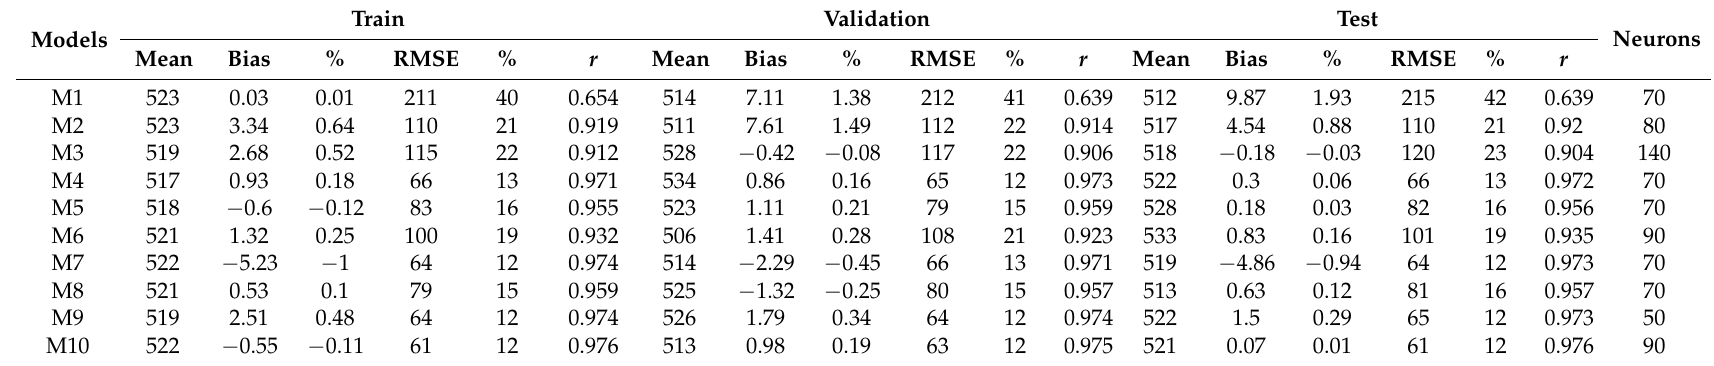
Table A1. Statistical results of hourly GHI models and neuron numbers in the hidden layer for Batufa tower station. Mean, bias and RMSE units are W/m 2 .